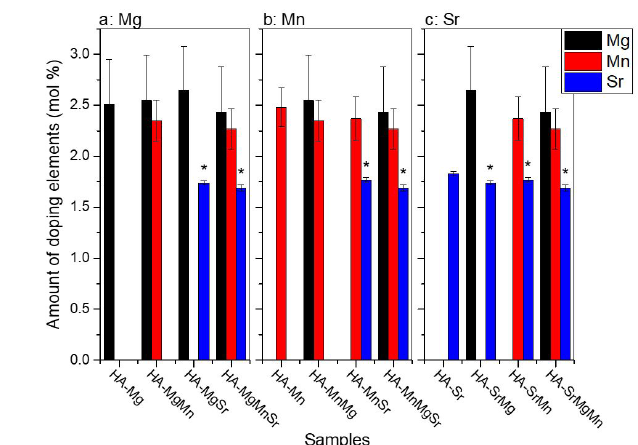
Figure 1. Amount of each dopant in the samples as measured by WDXRF. The effect of Mn 2+ and Sr 2+ on the amount of Mg 2+ (a), the effect of Mg 2+ and Sr 2+ on the amount of Mn 2+ (b), and the effect of Mg 2+ and Mn 2+ on the amount of Sr 2+ (c). *Significantly different from the amount of the element in the initial mixture: Mg 2+ (a), Mn 2+ (b) and Sr 2+